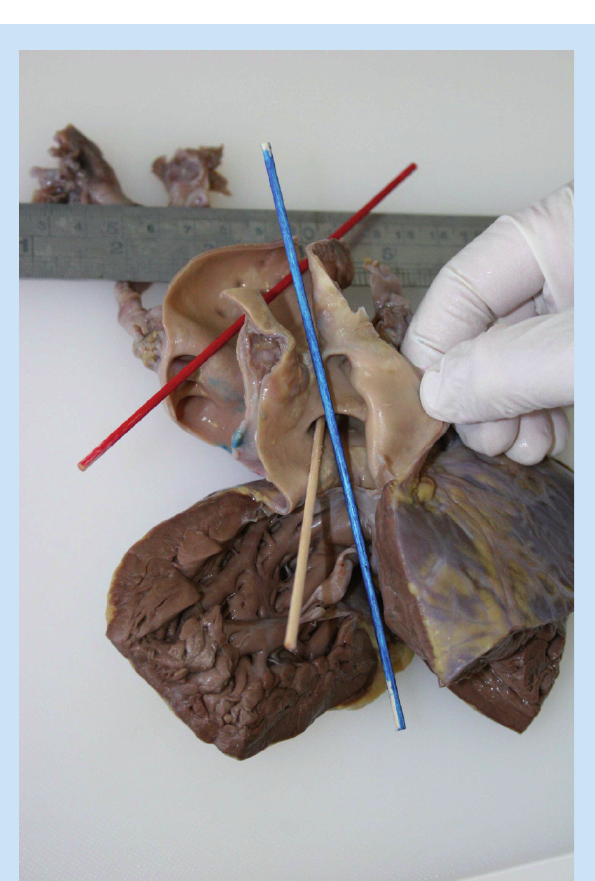
Fig. 6. Postmortem specimen: Blue stick – PDA; red stick – aorta; beige stick – pulmonary trunk.